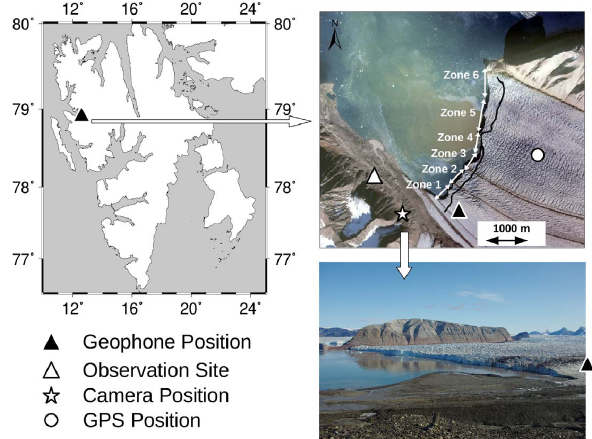
Fig. 1. Location of Kronebreen on Svalbard and position of instru- mentation and observation site close to the calving front. Upper photo was taken in 1990 (Norwegian Polar Institute). Zones are in- dicated used to locate direct calving observations. Zone 6 comprises 700m of the northernmost part of the glacier front, Zone 5 ranges from 700 to 1500m, and Zone 1 to 4 are 500m long each. Black line is front position on 29 August 2008. Lower photo shows view of glacier front as seen from the camera position close to the visual observation site in